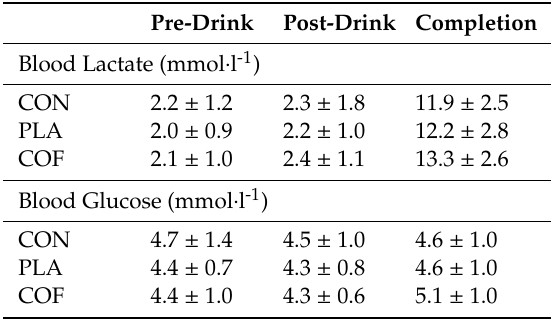
Table 1. Mean ± SD lactate and glucose concentrations during the 5 km cycling time trial ( n = 38).